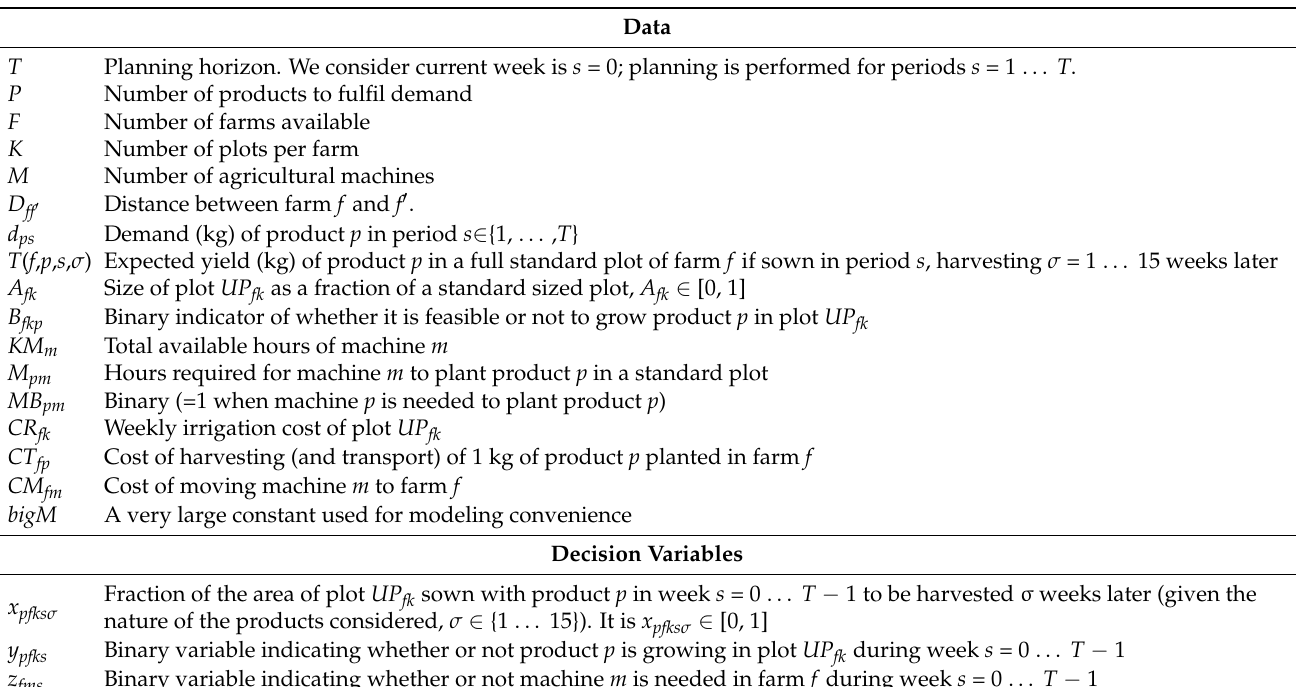
Table 1. Data and decision